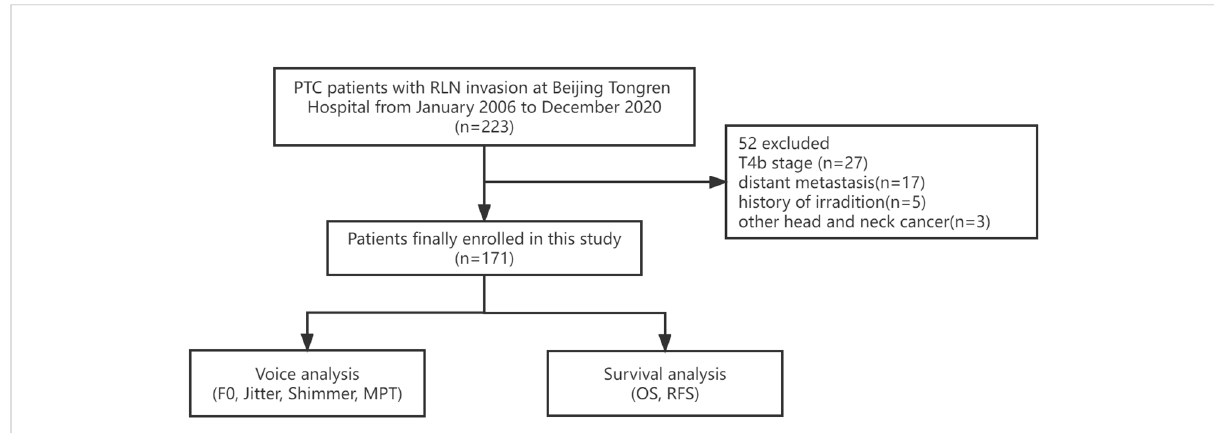
FIGURE 1 The work fl ow of this